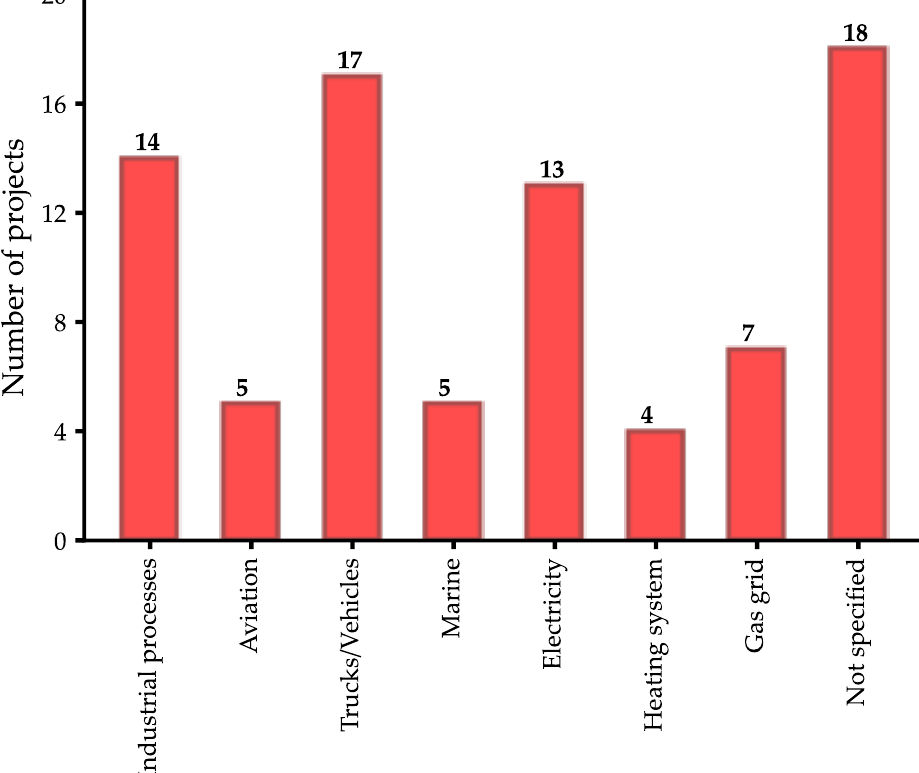
Figure 8. Number of projects per final utilization.